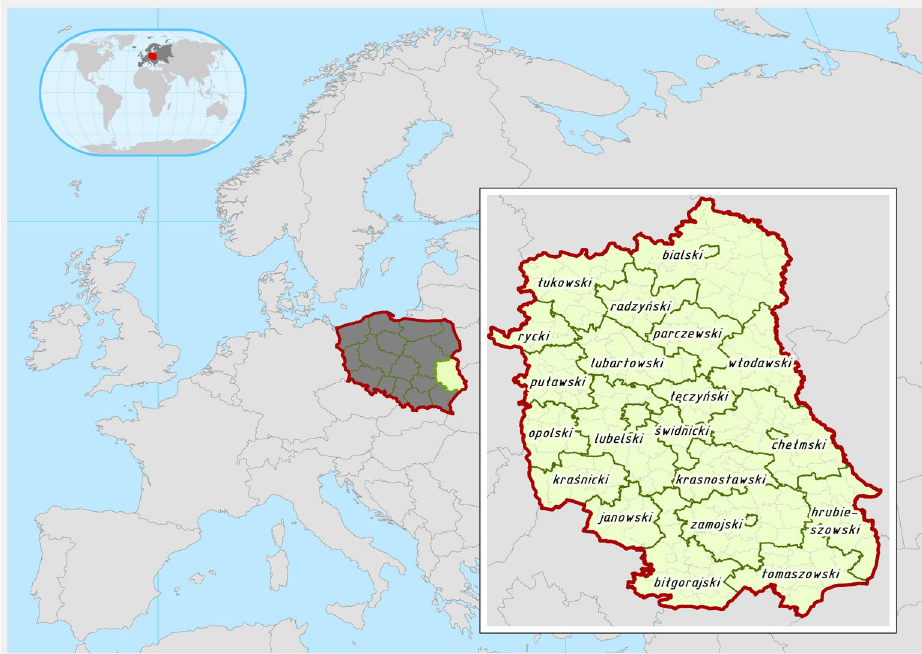
Fig. 1. Lubelskie region and its division at NUTS 4 (powiat)